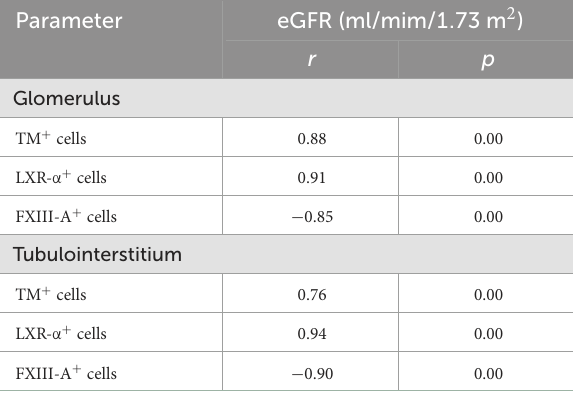
TABLE 2 Correlation analysis between TM + , LXR- α + , FXIII-A + cells with eGFR level in DN